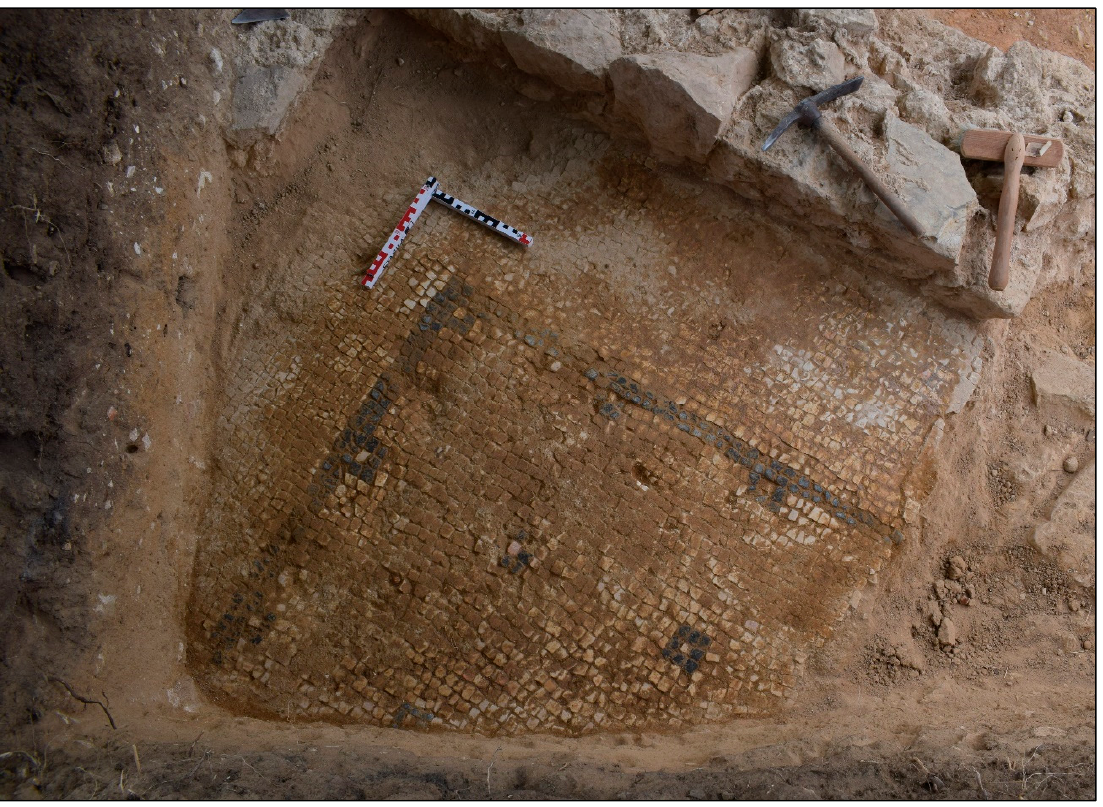
Figure 13. Mosaic documented in an archaeological sounding (P1-1).